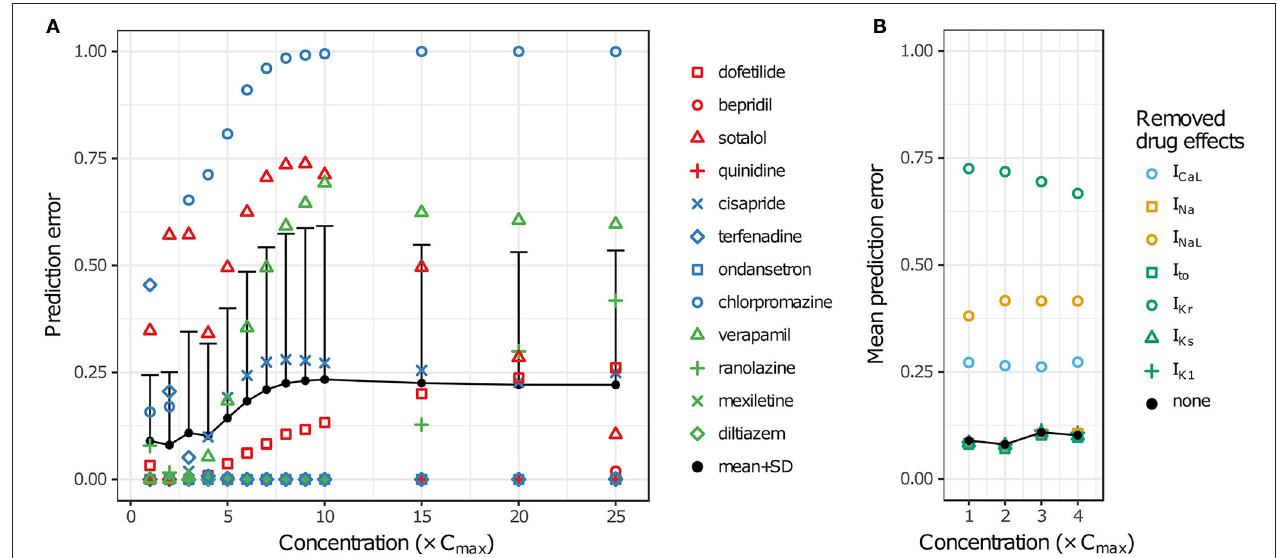
FIGURE 7 | Cross validation of TdP risk stratification with uncertainty quantification. LOOCV was performed at each concentration to assess TdP risk stratification performance. Prediction error for each drug was obtained by training on qNet distribution samples from all other drugs and calculating the mean classification error of the test drug’s samples. (A) LOOCV at 1 − 25 × C max . Markers show the prediction errors for each drug when it was “left out,” as indicated in the legend. Black points and error bars are the mean + standard deviation (SD) of prediction errors at each concentration. High TdP-risk drugs are in red, Intermediate-risk drugs are in blue, and Low-risk drugs are in green. (B) LOOCV at 1 − 4 × C max was repeated with the drug effects for a particular ionic current removed. Black points are the mean prediction errors from (A) . Markers show the mean prediction errors that resulted when drug effects on the ionic current indicated in the legend were omitted from